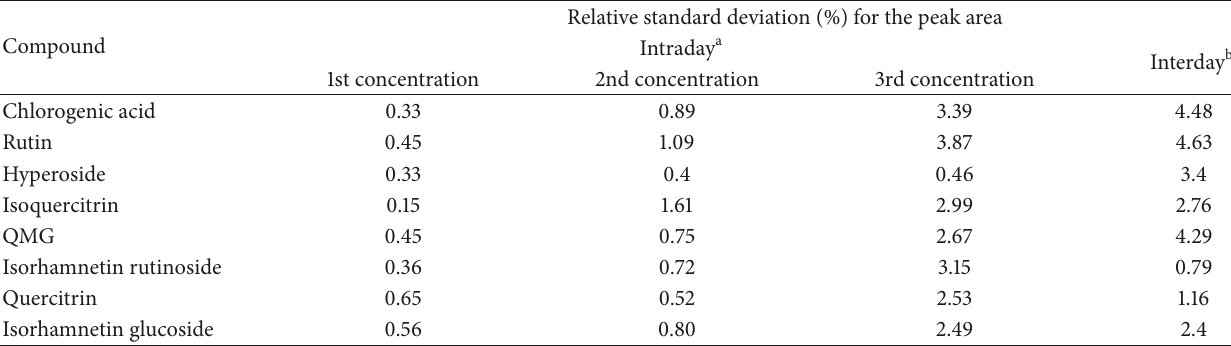
Table 2: Precision of the HPLC method for the quantitative determination of phenolic compounds.